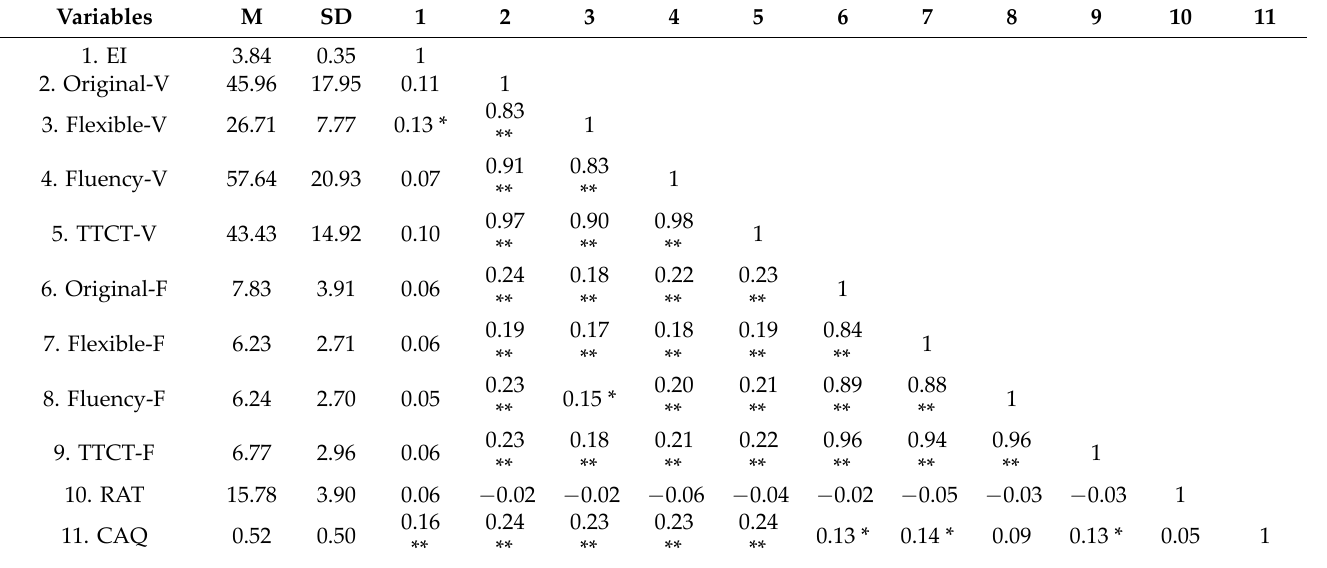
Table 4. Descriptive statistics and correlations between EI and